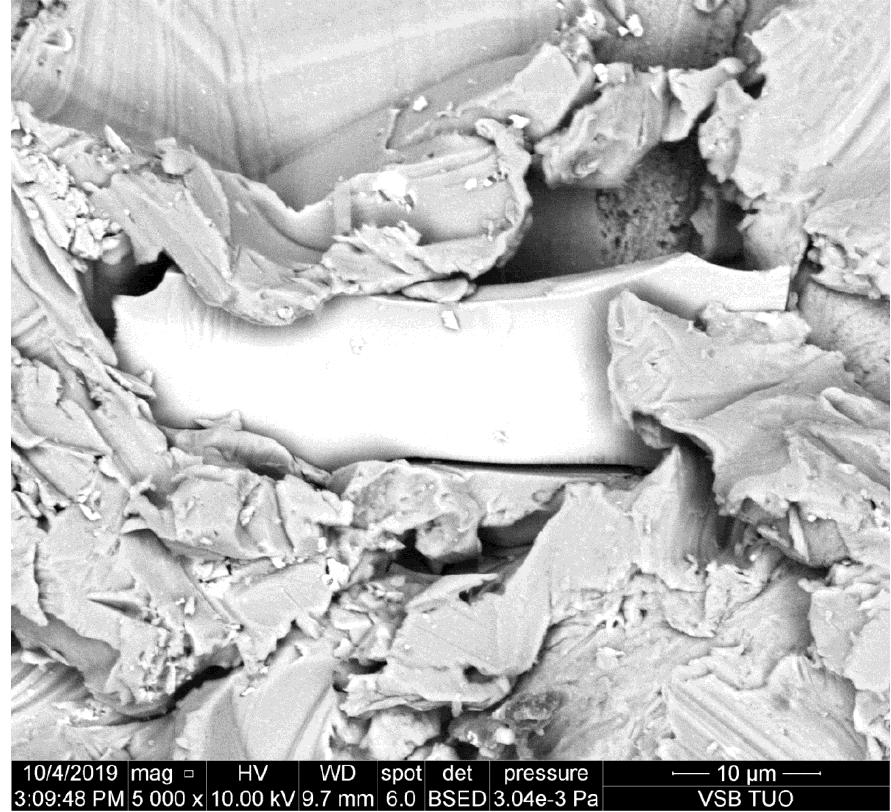
Figure 1. Abrasive particle pressed into the sidewall of the kerf made in duralumin.